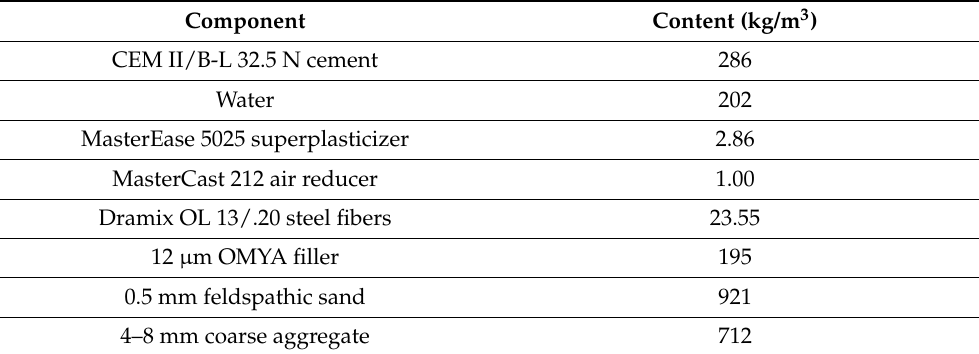
Table 1. Dosage of the concrete mix.